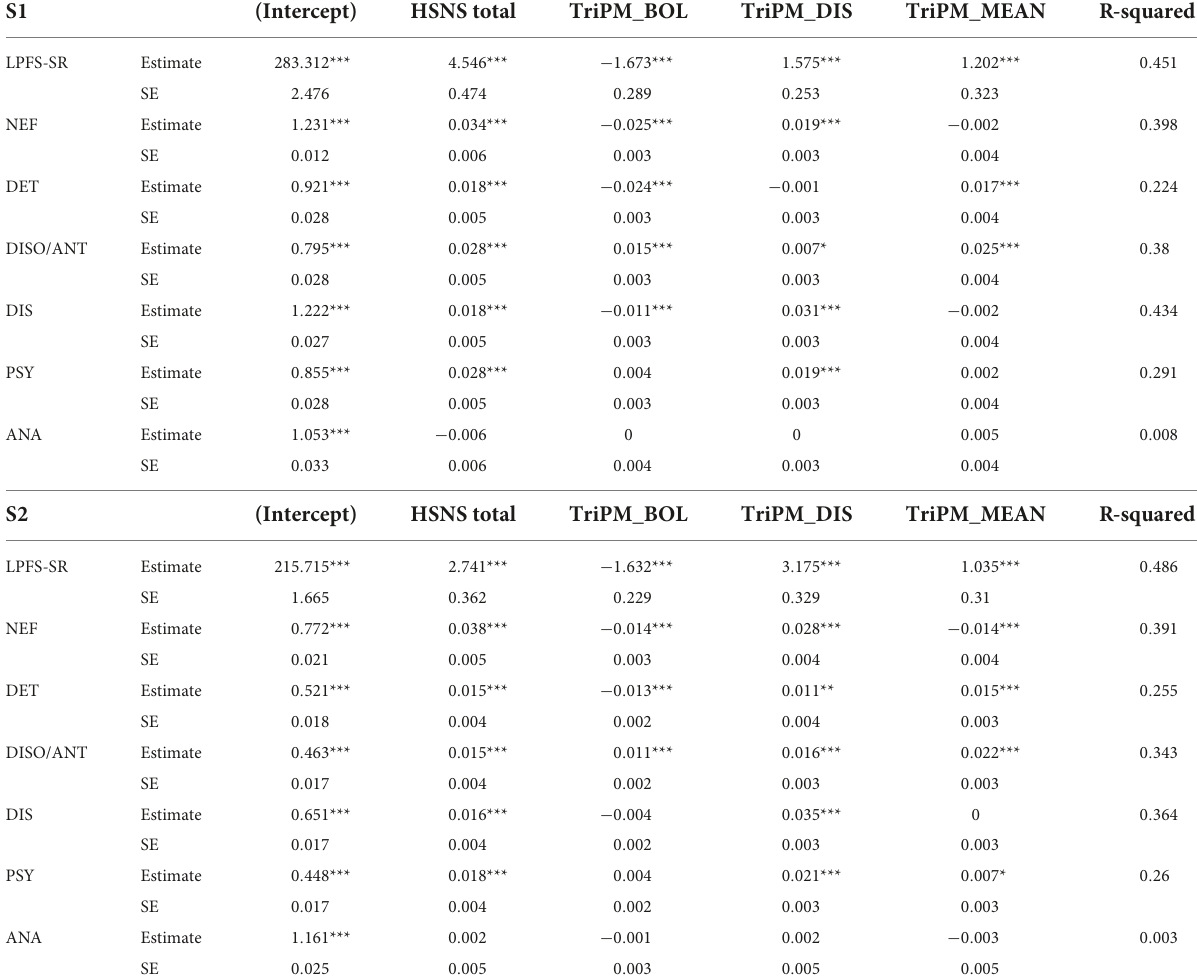
TABLE 1 Prediction of narcissistic features in LPFS-SR and PID5BF+M domains in both samples.